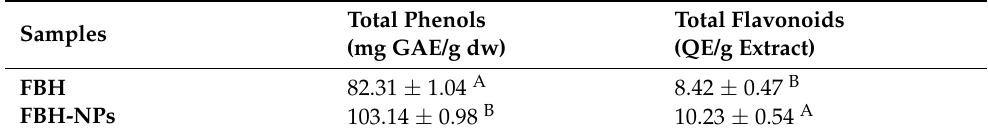
Table 1. Total phenols (mg GAE/g dw), total flavonoids (QE/g extract) contents of FBH and FBH-NPs. Samples